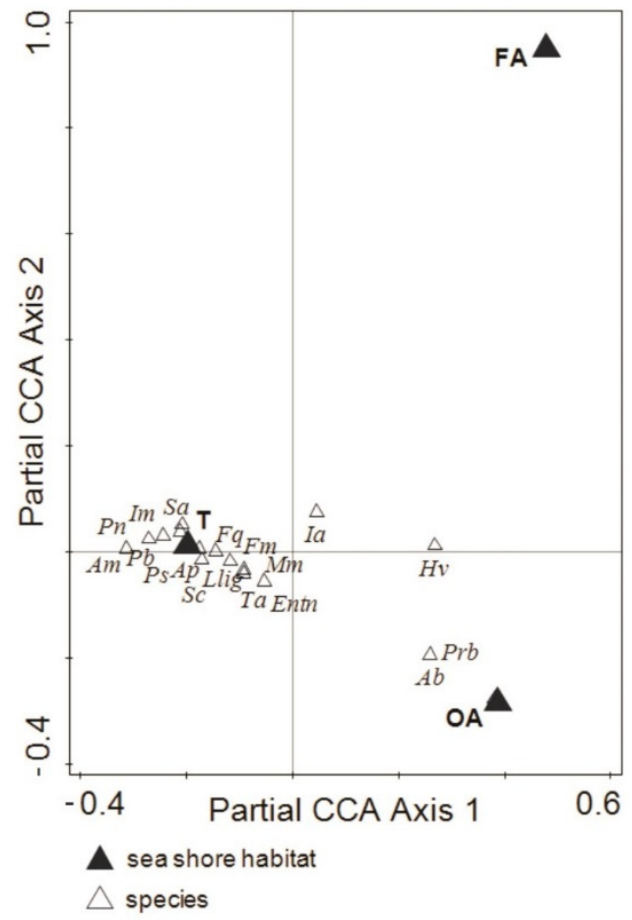
Figure 3. Ordination of the Collembola species in different macroalgal patches and coastal tundra of the Barents Sea. A partial constrained analysis (pCCA) with site (B) and time (Tm) as covariates calculated with log(x10 + 1)-transformed species data; significance level of the effect attributable to covariate bay as block tested by Monte Carlo permutation test under a model with 499 permutations. The full names of the abbreviated species are given in Table 3. T: coastal tundra, OA: old algae (decaying macroalgae debris), FA: fresh algae (living macroalgae).